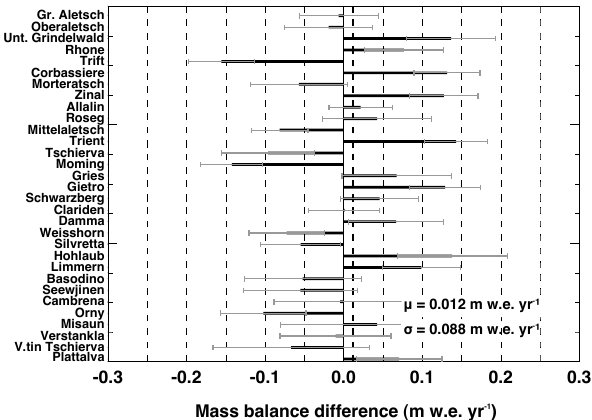
Figure 6. Validation of average geodetic mass balance with mass balance data derived from independent DEMs created using pho- togrammetry (Huss et al., 2010a, b). The mean difference µ , for which the standard deviation at the 1 σ level is also given, is indi- cated with the bold dashed line. Individual glaciers are sorted ac- cording to their area. Error bars indicate the glacier-individual un- certainty in the geodetic mass balance ( ± σ geod ,g /(cid:49)t ).